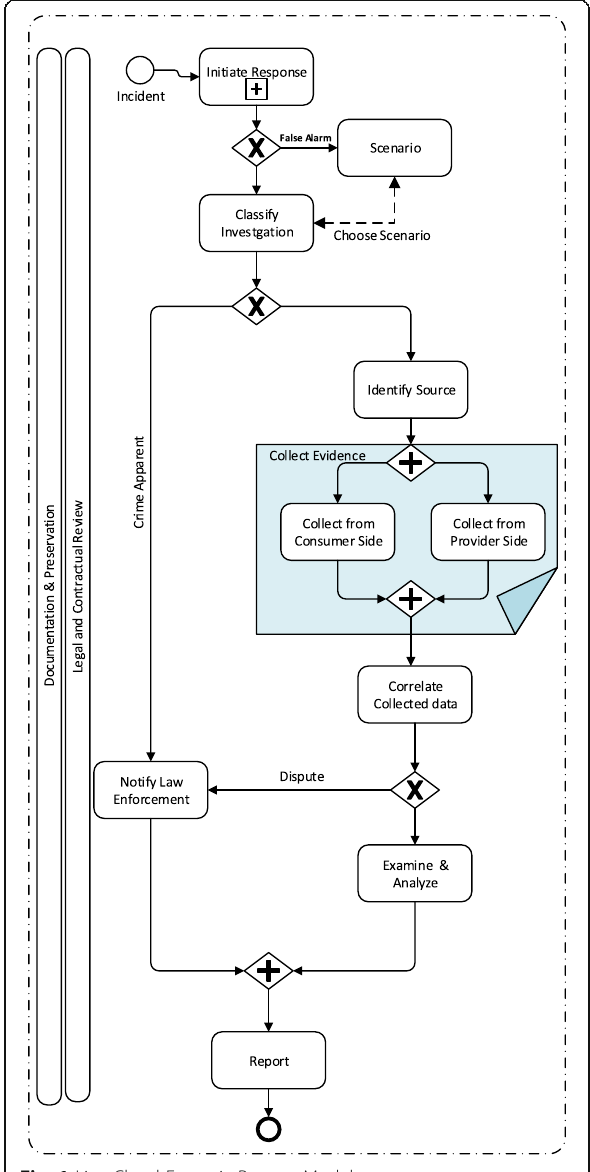
Fig. 1 Live Cloud Forensic Process